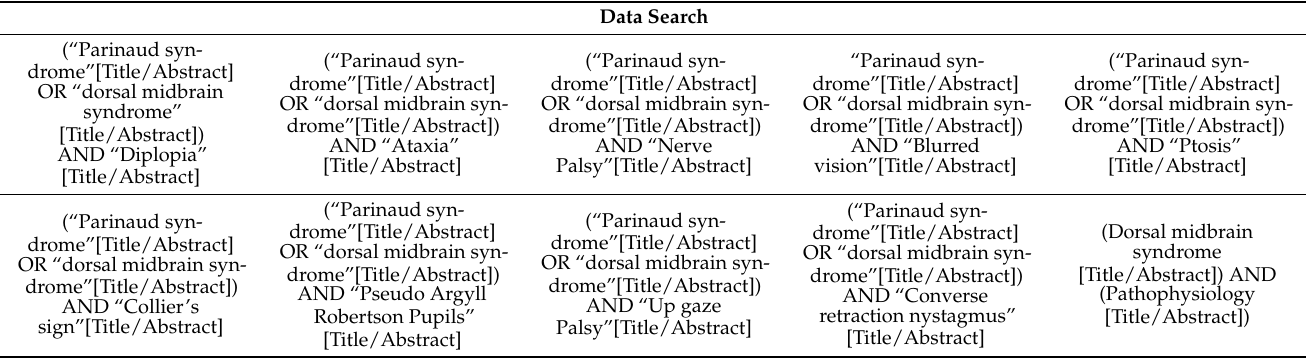
Table 1. Search terms for the information in this review. Data